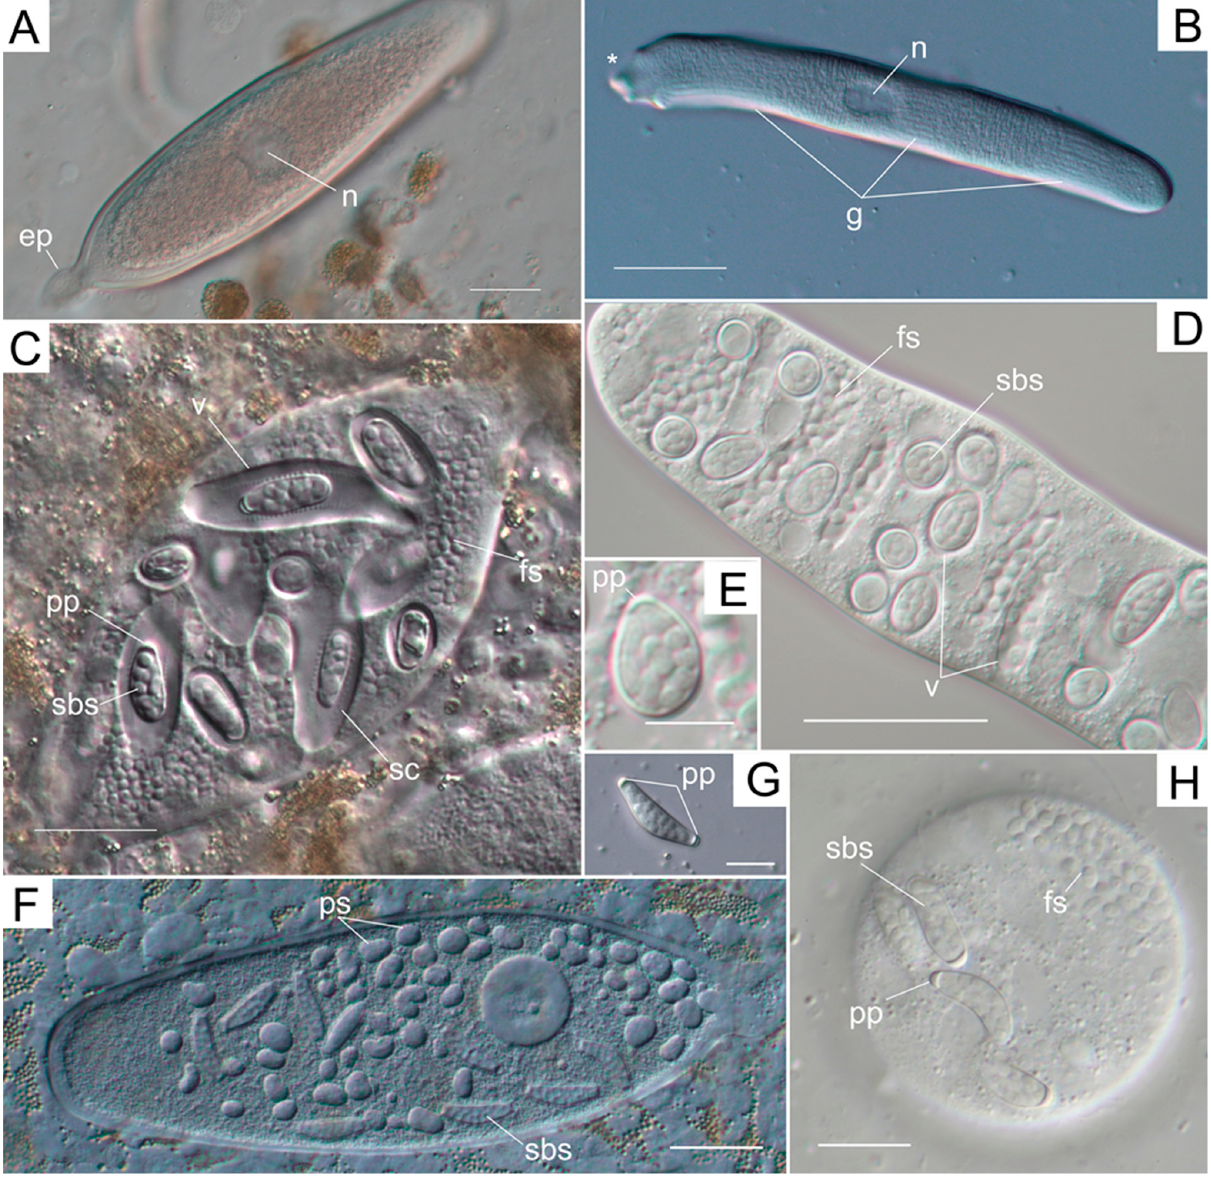
Figure 2. Primary and secondary parasites of the polychaete Pygospio elegans under Leica DM 2500 microscope equipped with DIC optics and Plan-Apo objective lenses and photographed using DFC295 digital camera ( A – C , F , G ) or a Nikon DS-Fi3 digital camera ( D , E , H ). ( A ) Live uninfected Polyrhabdina pygospionis trophozoite with epimerite ( ep ) and one nucleus ( n ); ( B ) Live uninfected Selenidium pygospionis trophozoite with one n and pellicle longitudinal grooves ( g ) seen in focal plane, asterisk marks the anterior end of the cell; ( C ) P. pygospionis infected with Metchnikovella spiralis , the hyperparasite forms the clusters of free spores ( fs ) and sac-bound spores ( sbs ), spore sacs have one polar plug ( pp ) and exterior spiral cord ( sc ), spore sacs are enclosed in vacuoles ( v ); ( D ) S. pygospionis filled with M. dobrovolskiji fs and sbs , both spore sacs and fs are enclosed in v ; ( E ) spore sack of M. dobrovolskiji has one pp ; ( F ) P. pygospionis with sbs and proliferative stages ( ps ) of M. incurvata ; ( G ) isolated spore sac of M. incurvata with two pp ; ( H ) S. pygospionis filled with M. dogieli fs and sbs , spore sacs with one pp . Scale bars: ( A – D )—20 µ m, ( E )—5 µ m, ( F )—30 µ m, (G , H )—10 µ